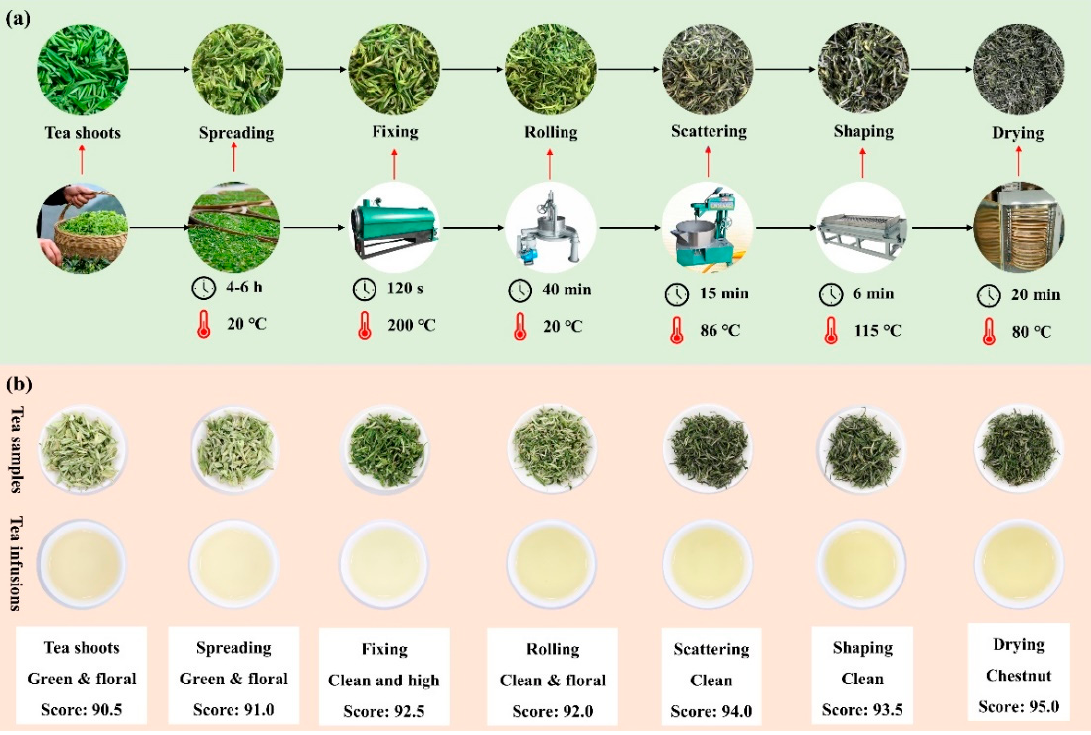
Figure 1. The XYMJ green tea manufacturing flow chart ( a ) and aroma sensory evaluation of the processed XYMJ green tea samples ( b )